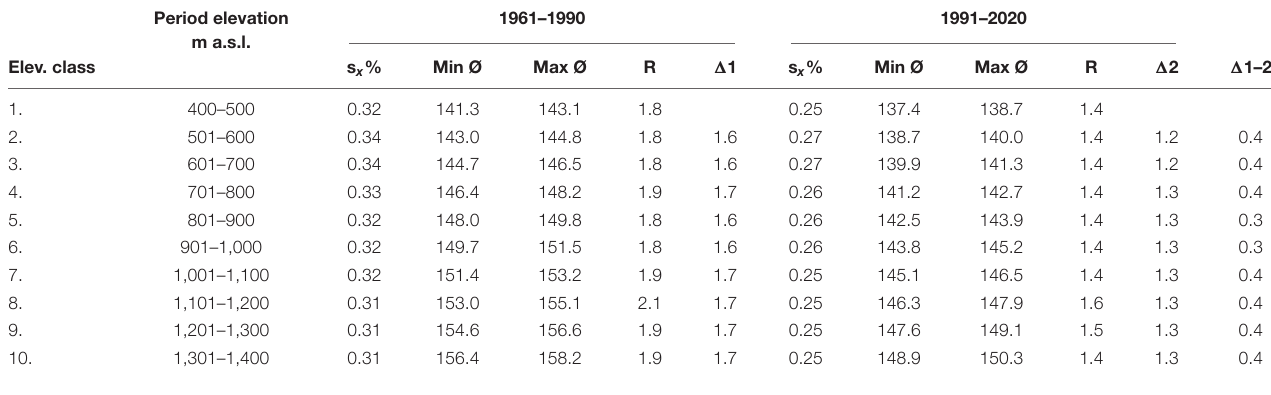
TABLE 3 | Selected statistical characteristics of flowering of Picea abies (L.) Karst. [s x %—coefficient of variation, min—earliest average onset (doy), max—latest average onset (doy), R—variation range, (cid:49) —difference between elevation classes (day)]. Period elevation m